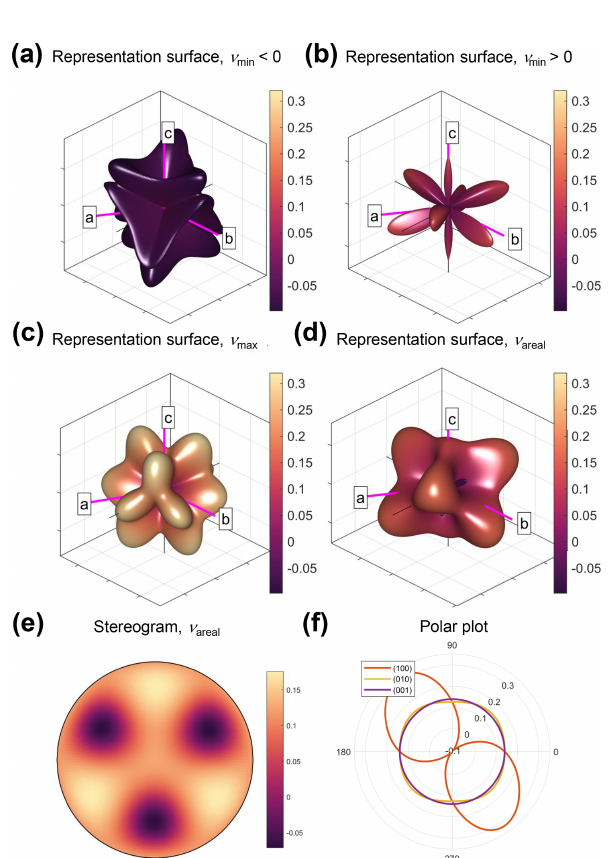
Figure 6. Alternative visualisations of the anisotropy of Poisson’s ratio ( ν ) of α -quartz. (a–d) 3D representation surfaces where the ra- dius in any direction is proportional to the magnitude of ν . Separate surfaces shown for minimum negative, minimum positive, maxi- mum and areal ν, as defined in the equations in Sect. 2. (e) Lower- hemisphere equal-area stereographic projection of ν areal . (f) Polar plots of anisotropy of ν in selected planes. Crystallographic axes (cid:104) a (cid:105) , (cid:104) b (cid:105) and (cid:104) c (cid:105) shown in pink.